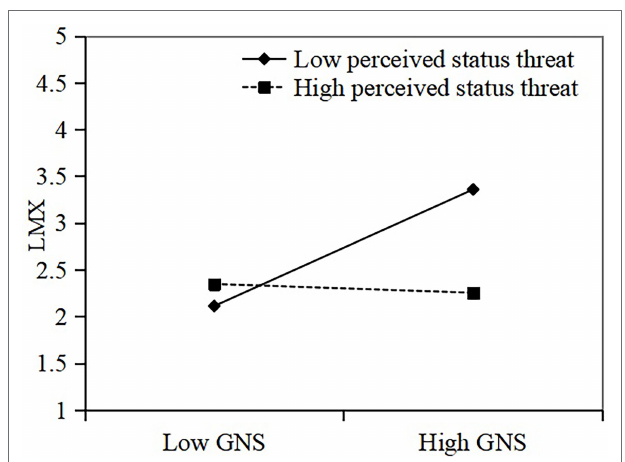
FIGURE 2 | Interaction impacts of GNS and perceived status threat on LMX.